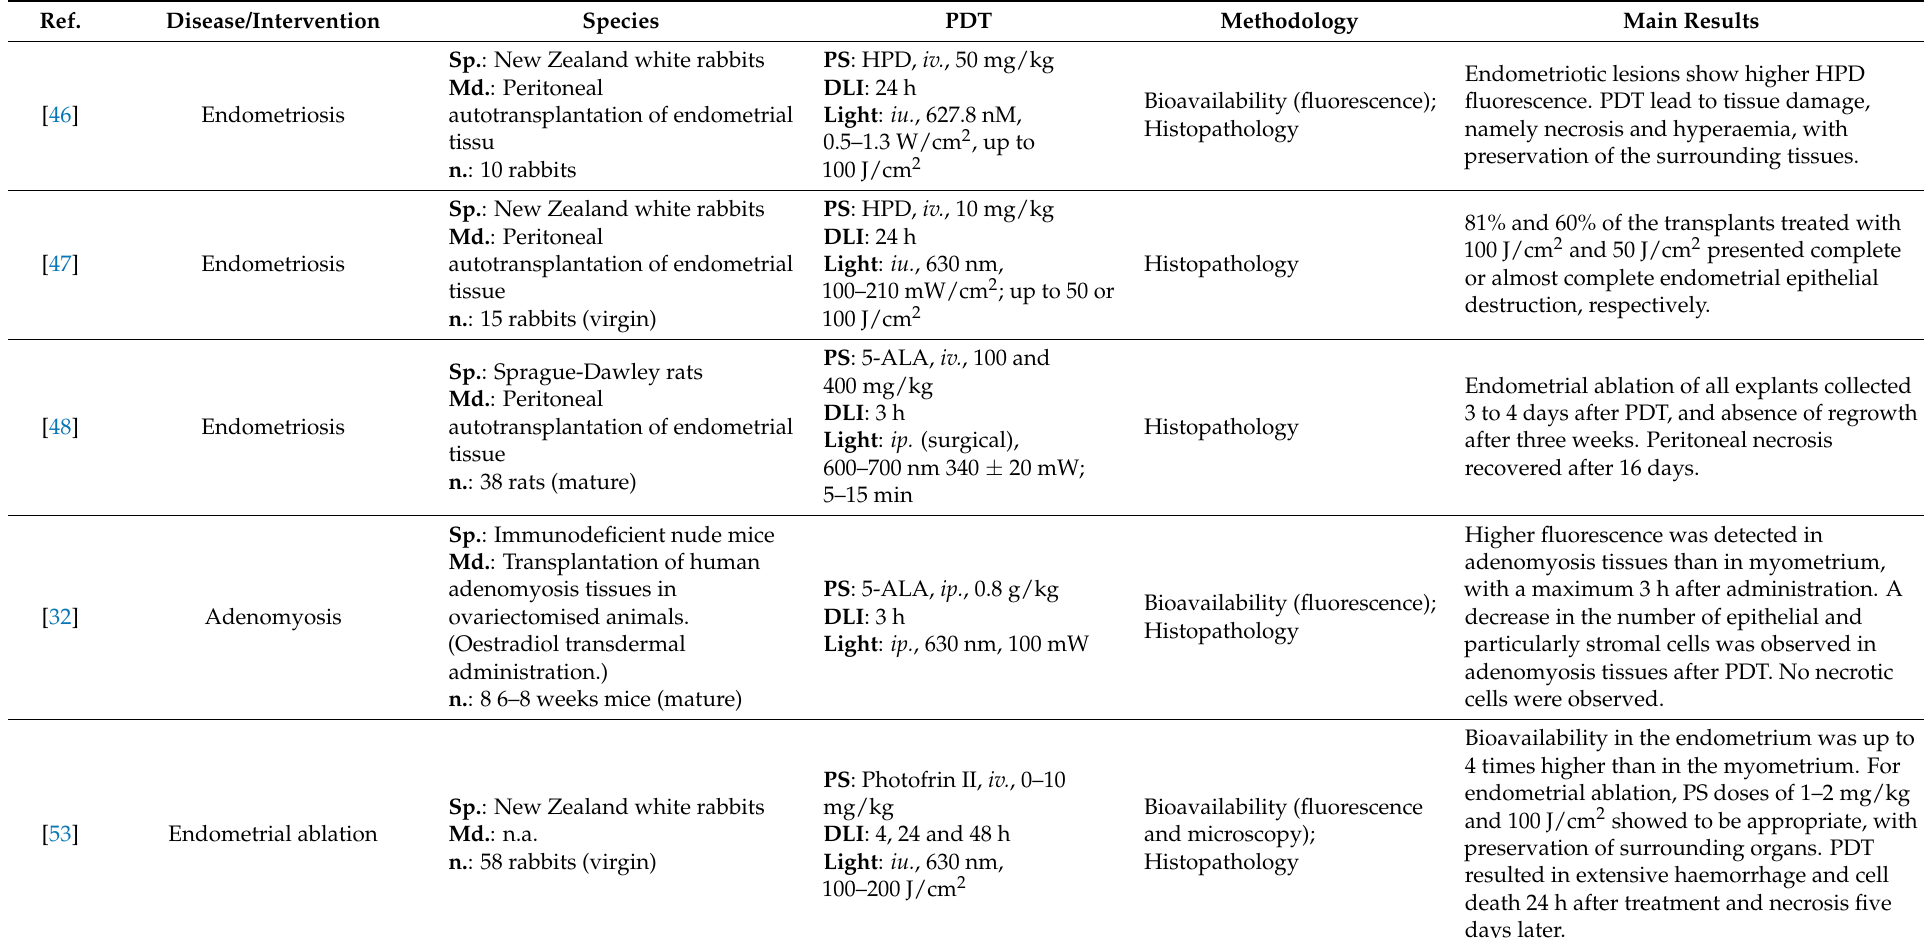
Table 2. In vivo